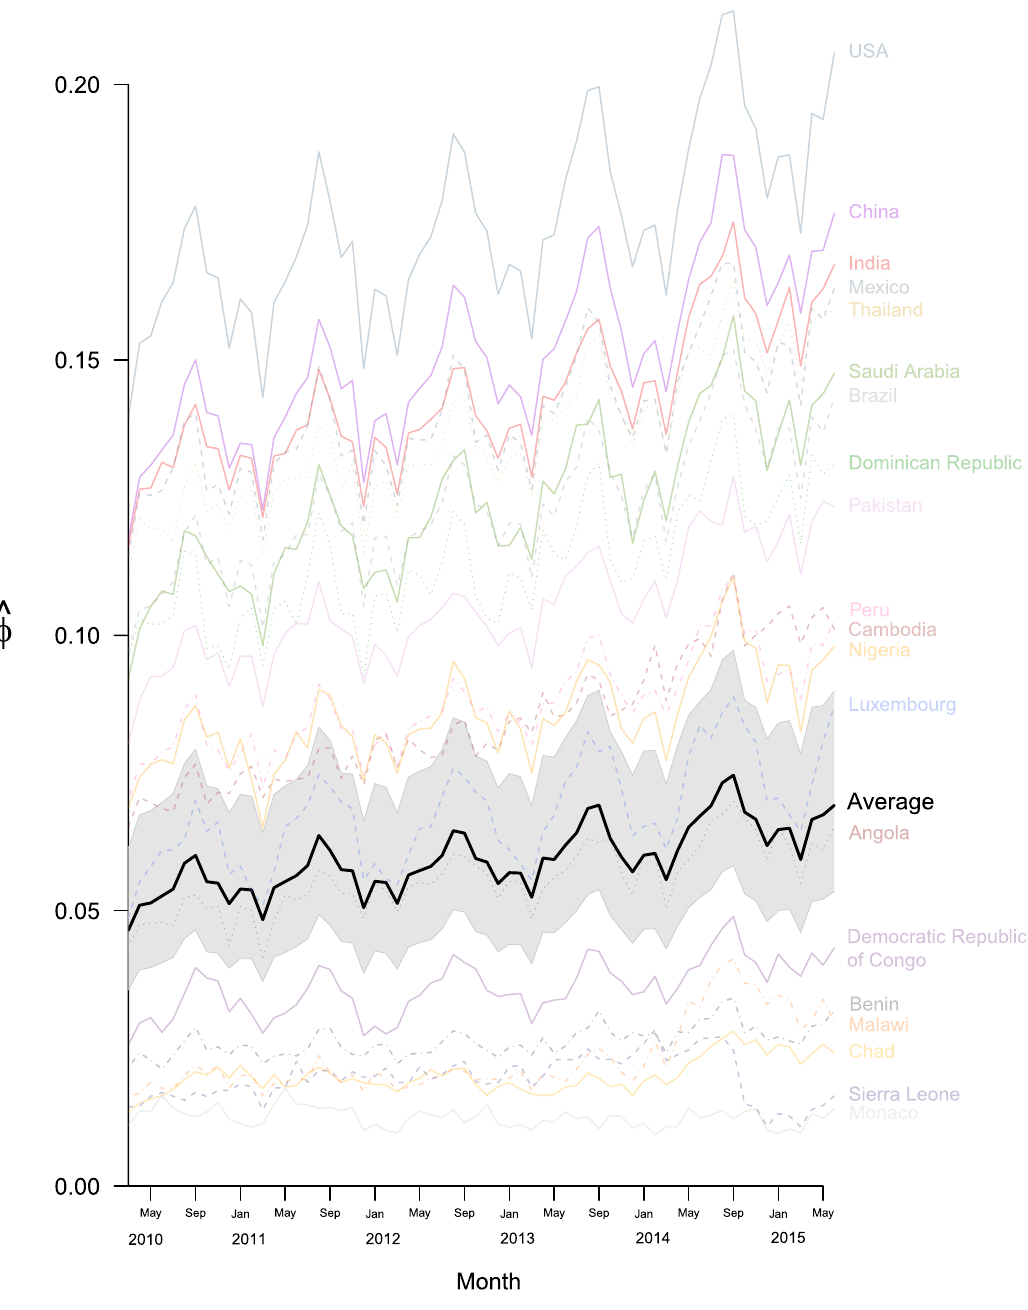
ˆ φ Figure 1. Average global connectivity ( ) for the period ranging from January 2010 to May 2015, highlighting the global average (with confidence intervals in grey) as well as specific countries of